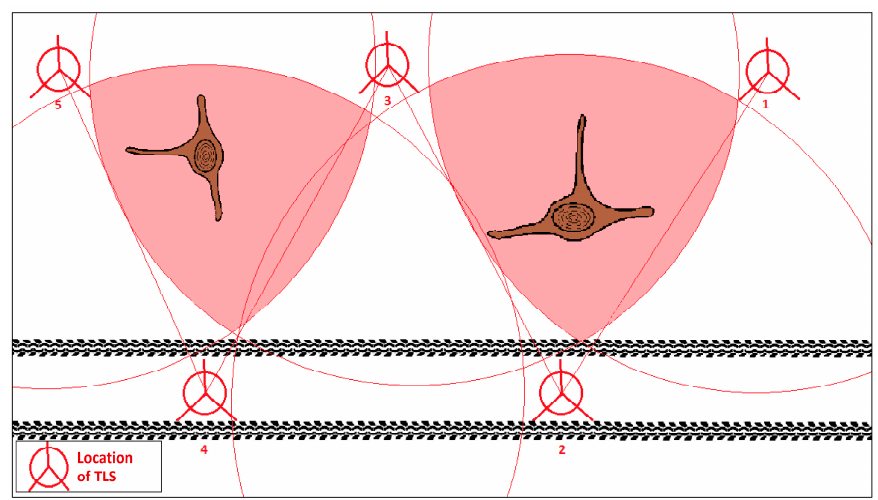
Figure 2. Schematic of an optimal scanning pattern to allow visualization and measurements of the stumps and machine operating trail.